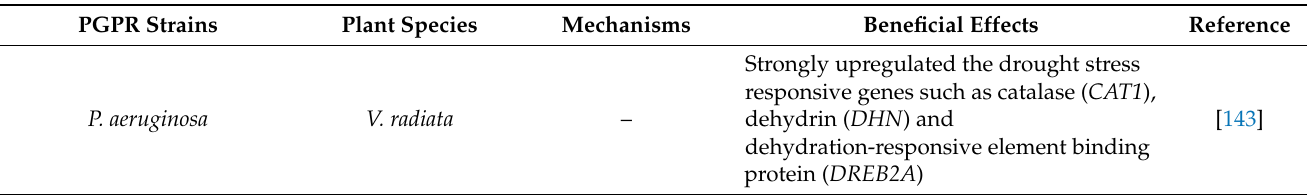
Table 3. PGPR-mediated alteration of stress responsive gene expression in plant drought stress